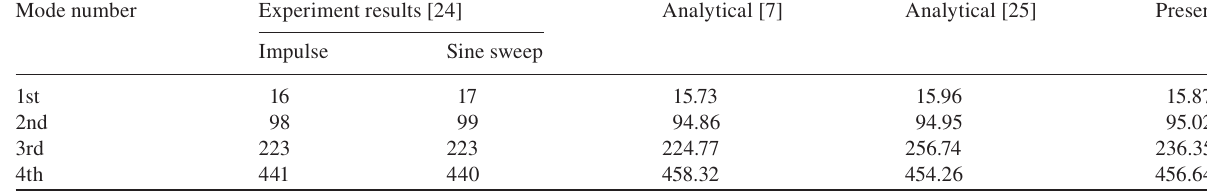
/ τ for different vertical locations of delamination. (C, D) Variation of w– f L– = 0.3, L– = d 1